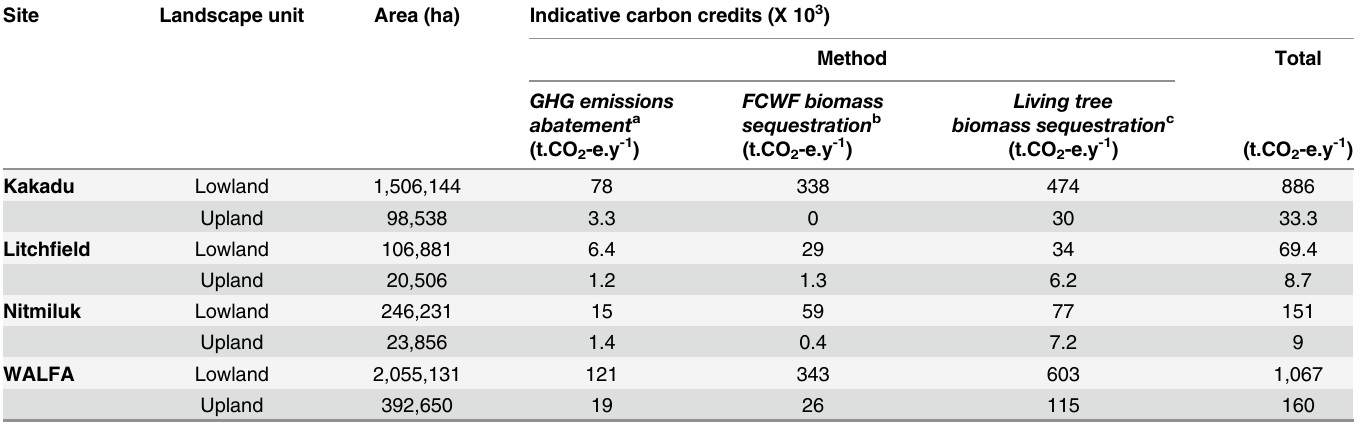
Table 4. Indicative carbon credits feasibly generated using three complementary savanna burning methodologies under enhanced fire manage- ment. (1) each t.CO 2 -e.y -1 abated or sequestered = 1 carbon credit; (2) enhanced fire management scenarios based on published experience with WALFA [55]; FCWF = fine and coarse woody fuels; (3) for sequestration methods, carbon credits are annualized over 25 years. (4) Brief footnotes concerning method uncertainties are provided below; other details concerning respective methods, calculations, and management assumptions are presented in Supporting